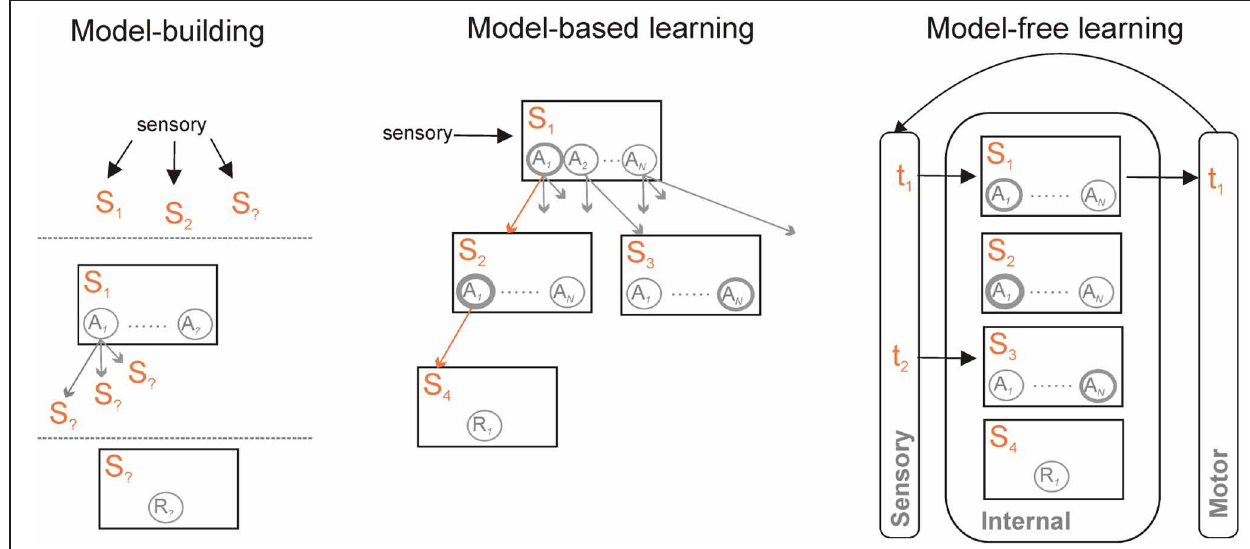
FIGURE 1 | Model-based and model-free learning and controllers. Model-based and model-free controllers represent the world as a set of states S 1 ... S m and actions A 1 ... A N within those states. They learn the values of each action in a given state, here indicated by the thickness of each circle, based on available rewards R . What distinguishes them is their representation of the links between those states. A model-based controller (centre) also represents the transitions between states and the action(s) that cause the transition (indicated by the multiple arrows). For a known current state, specified by current sensory information, the model can be traversed to find the likely outcome of simulated actions in each state—one such trajectory is given by the orange arrows. Each trajectory can then be used to update the predicted value of each action. Finally, after a number of trajectories through the model, an overt action is selected based on their